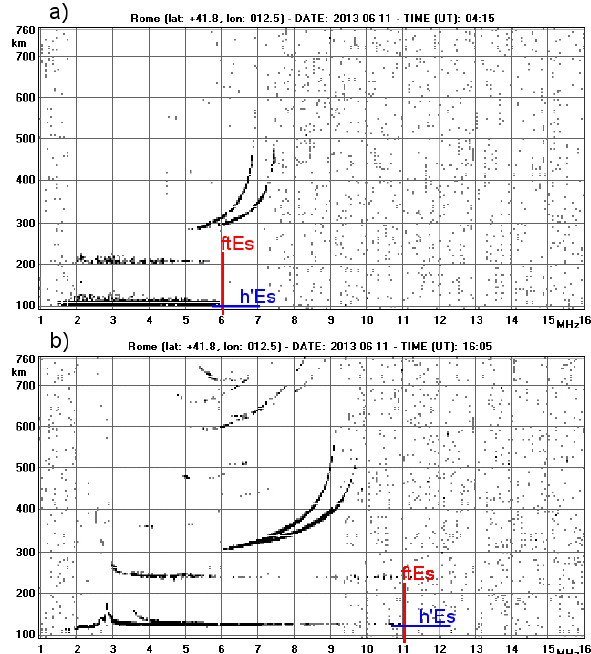
Figure 1. Examples of Es layer of (a) type “l” and (b) type “c” recorded at Rome in June 2013. The corresponding manually vali- dated ftEs and h’Es are respectively shown in red and